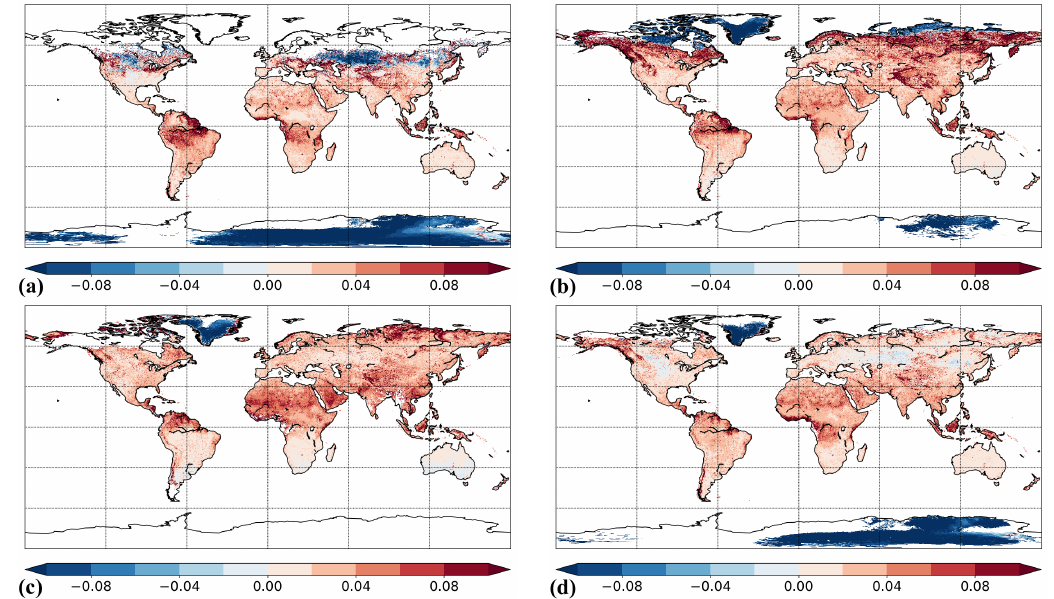
Figure 14. Mean bias of the surface albedo (ETAL-MODIS) for the period from January 2015 to December 2018 for: ( a ) December-January-February; ( b ) March-April-May; ( c ) June-July-August; and ( d ) September-October-November periods. The white color indicates the absence of data (either missing or filtered at the preprocessing